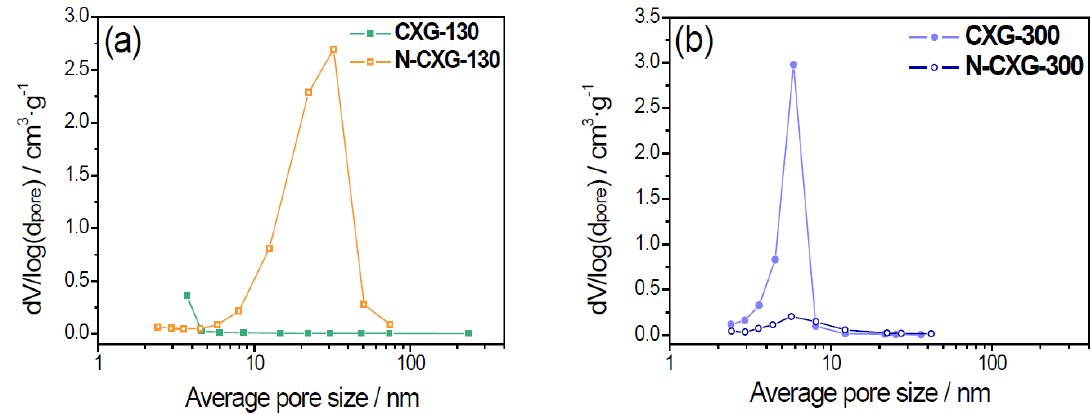
Figure 1. Pore size distribution for N-doped xerogels and their corresponding undoped counterparts ( a ) low R/C and ( b ) high R/C.